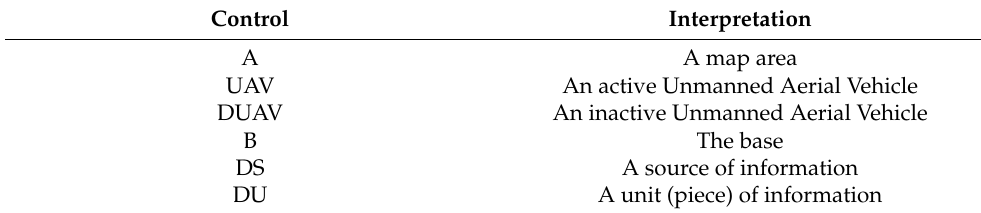
Table 5. A list of controls with their respective